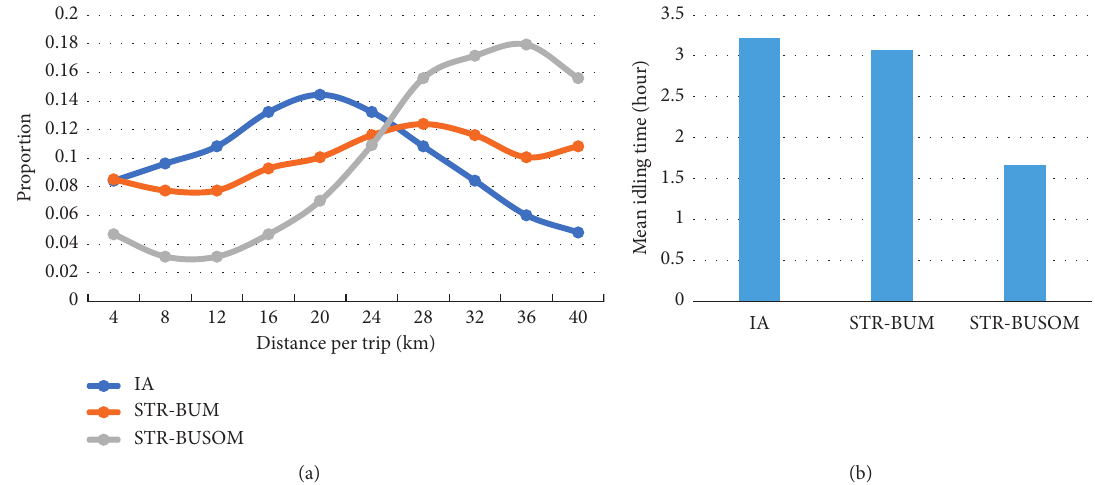
Figure 10: Detailed comparisons on performance of IA and STR. (a) Histogram of distance per trip. (b) Mean idling